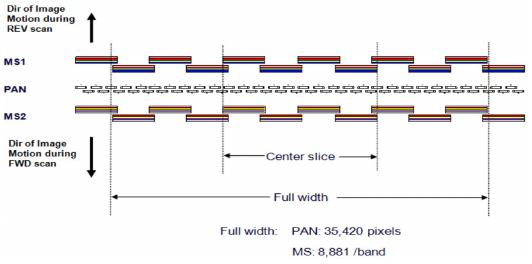
Figure 2: Focal plane assemblies of WorldView-2 (sketch cour- tesy Digital Globe)